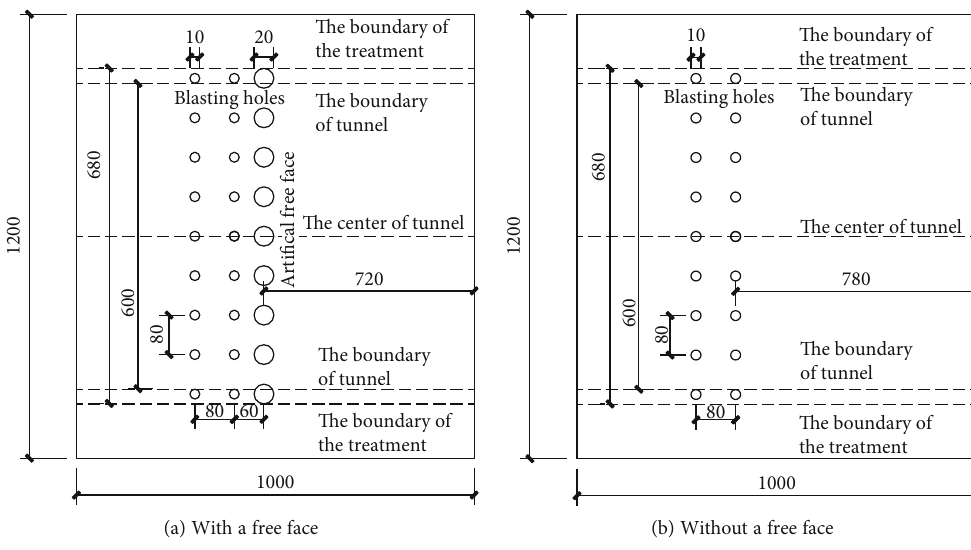
Figure 9: The numerical model plan (unit: cm).